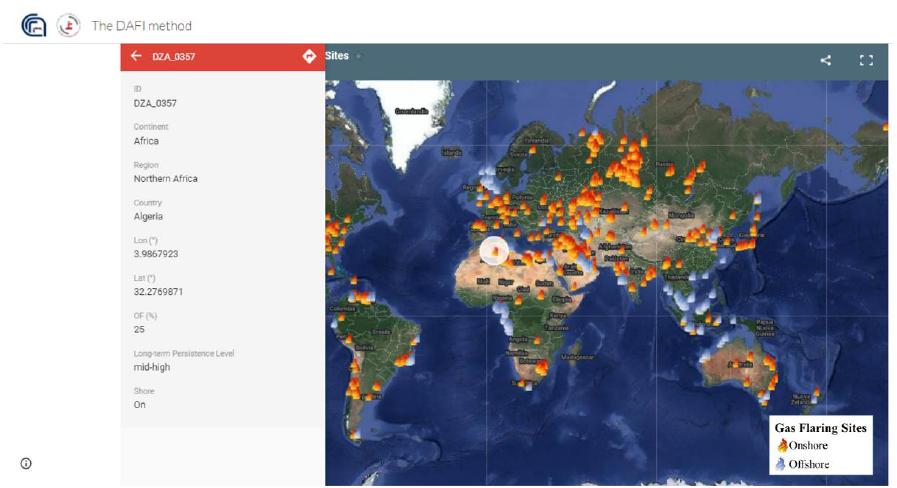
Figure 6. The global gas flaring DAFI map: onshore (orange flames) and offshore (blue flames) gas flaring sites. On the left side, a panel summarizing the GF features (e.g., DZA_0357). An identification code is assigned to each gas flaring site. It consists of the coun- try acronym (i.e., Alpha-3 country code) followed by a 4-digit progressive number (e.g., DZA_0357, see example in Figure 6). The dynamic characterization of the GF sites runs automatically in GEE. A schematic picture of the developed DAFI App is shown in Figure 7.